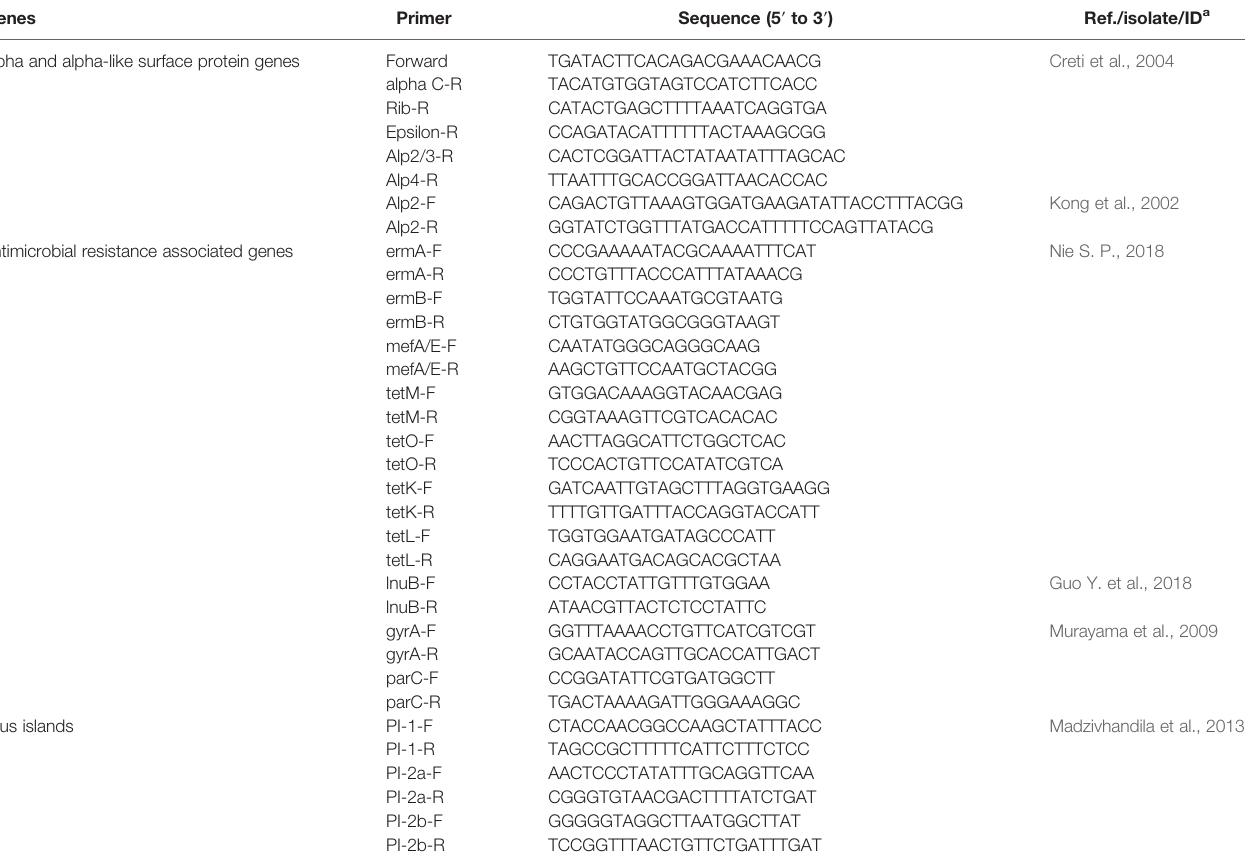
TABLE 1 | The primers used in the resistance and surface protein genes test and their reference.